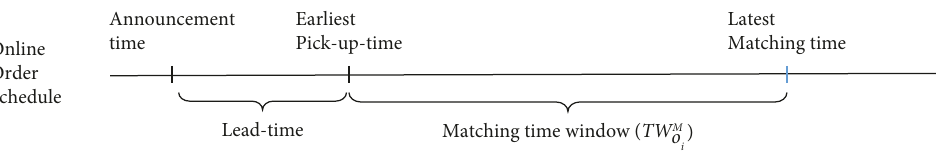
Figure 2: Matching time window for online orders. Table 1: Example bid list for the online order in Figure 1. Online order